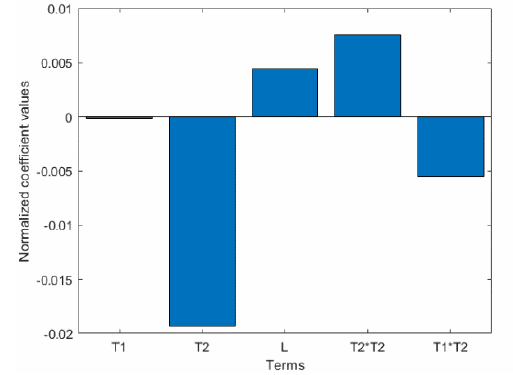
Figure 10. ν : normalized regression